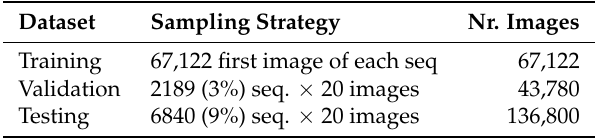
Table 1. Dataset sampling strategy for the stacked generalization model.